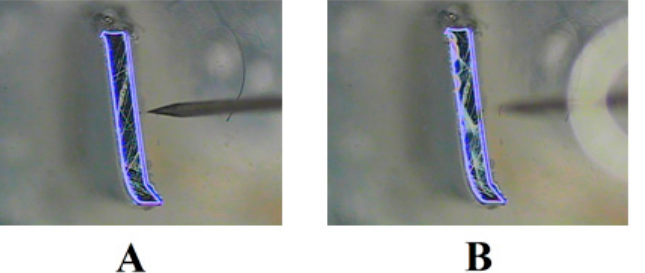
Figure 9. Optical micrographs of the cut edge of the complete coil coating steel sample immersed in a 1 mM NaCl solution. Duration of immersion in test solution: ( A ) freshly immersed, and ( B ) 165 min (immediately after SVET map recording in Figure 8B). The images were taken in situ using the video camera system coupled to the SVET equipment. The vibrating probe used to obtain the SVET maps can be seen in the center right of the micrographs.